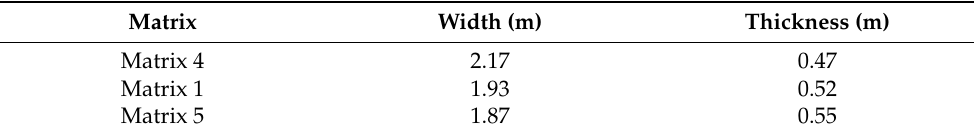
Figure 18. Effect of simultaneously changing the coke and ore angles in the matrix on the shape of the ore-free zone. Table 13. Width and thickness of the ore-free zone under the condition of simultaneously varying the coke and ore angle in the matrix.